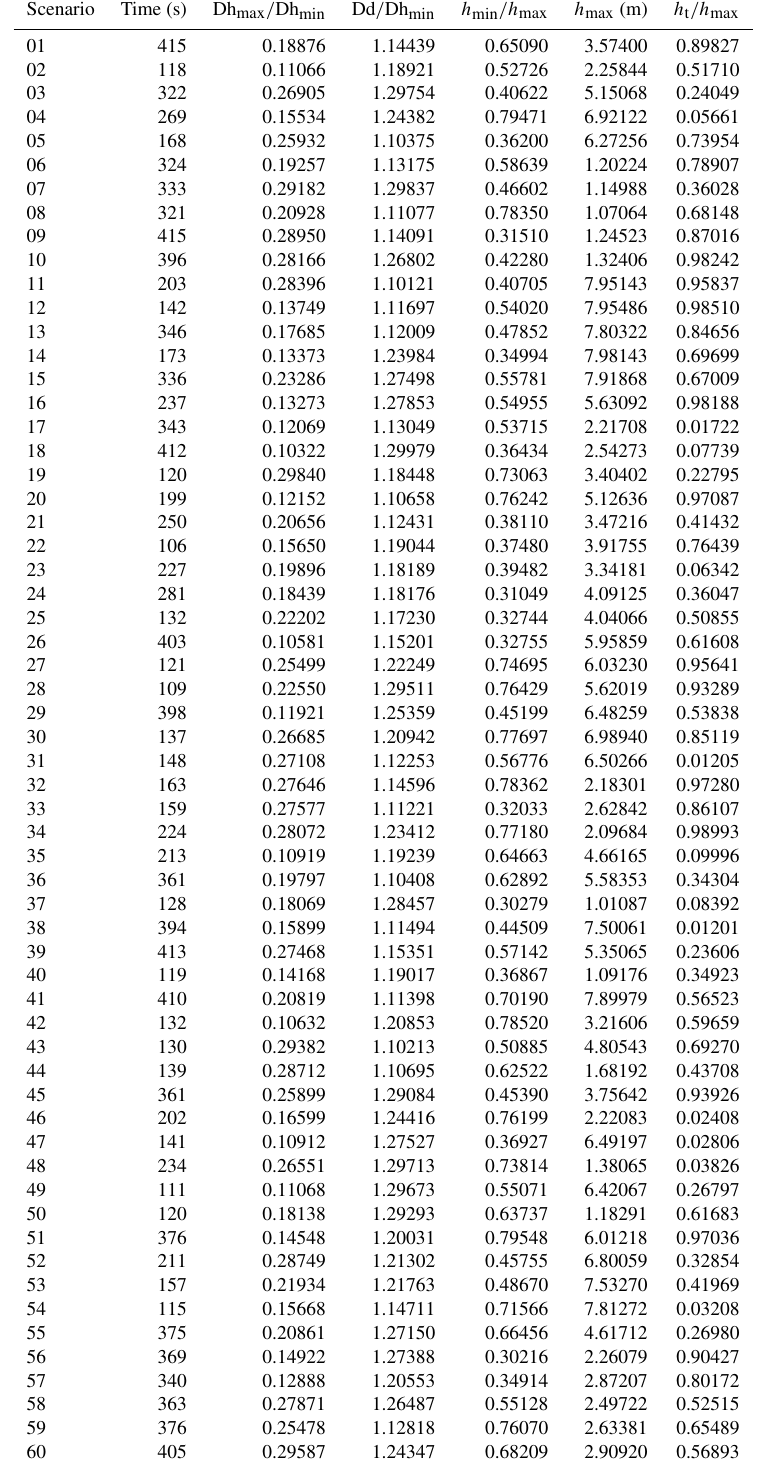
Table A1. Deformation scenarios selected by MICE to be used as sources in the tsunami